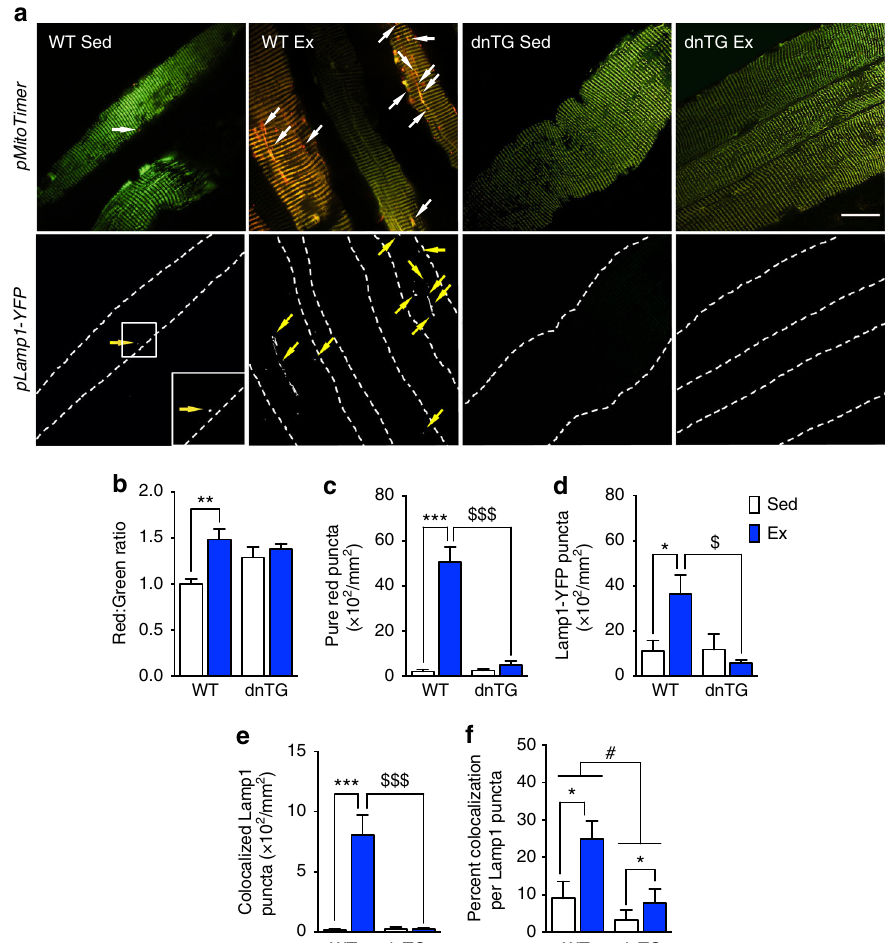
Fig. 5 Ampk is required for acute exercise-induced mitophagy and lysosomal genesis. a Representative images of WT and Ampk dnTG mouse FDB fi bers co-transfected with pMitoTimer and Lamp1-YFP . Scale bar = 20 µ m. Quanti fi cation of b red : green fl uorescence intensity (interaction effect p = 0.03), c pure red MitoTimer puncta per fi ber area (interaction effect p < 0.0001), d total Lamp11-YFP puncta per fi ber area (interaction effect p = 0.01), e